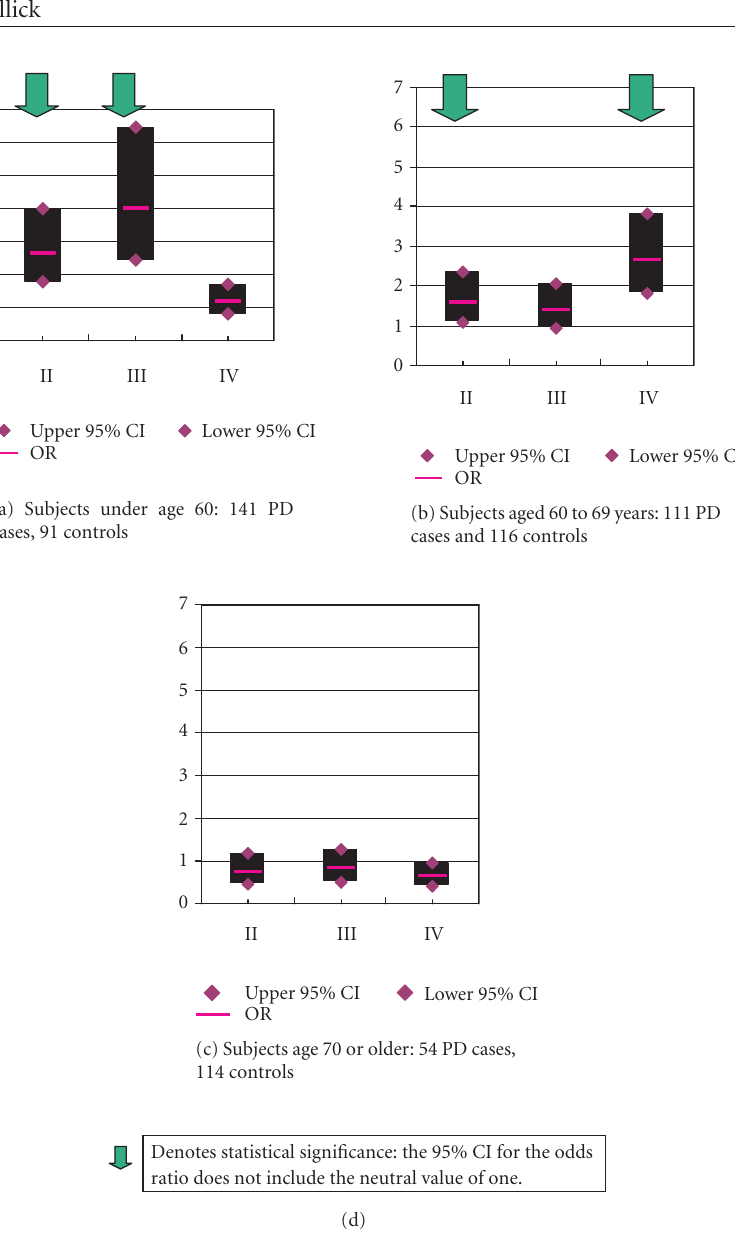
Figure 2: The odds of PD were estimated for each age group ( < age 60, 60 to 69, 70+) in logistic models. The predictors were membership scores in the vulnerable groups II, III, and IV. The scores were coded categorically from 1 to 5 representing 0 . 20 increments. Risk multiplies for each increment of 0 . 20. For example, at ages < 60, successive increments in group III membership carry risks of 4 (0 . 20–0 . 39), 16 (0 . 40 to 0 . 59), and 64 (0 . 60 to 0 .